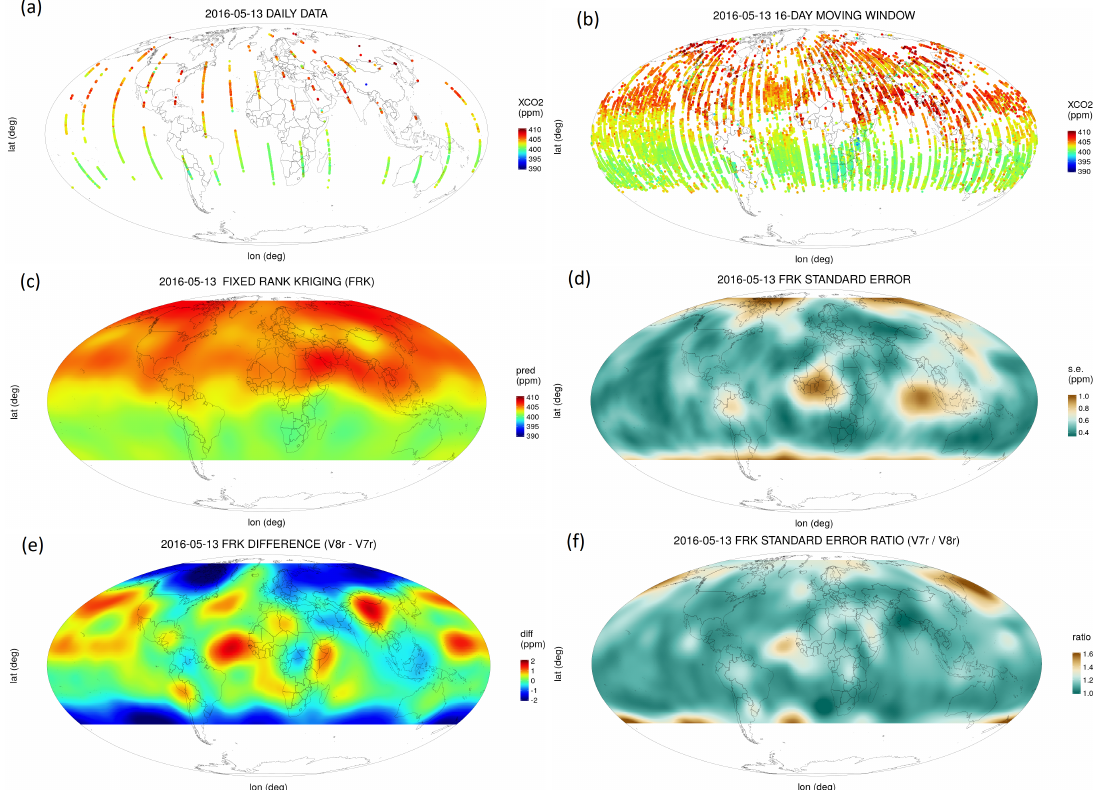
Figure 8. Fixed rank kriging (FRK) predictions of XCO 2 for 13 May 2016. ( a ) Orbiting Carbon Observatory-2 (OCO-2) Version 7r Lite File XCO 2 data with warn levels ≤ 15 on 13 May 2016; ( b ) same as (a), but for data between 6 May 2016 and 21 May 2016, inclusive; ( c ) global FRK Version 7r prediction (pred) of XCO 2 ; ( d ) global FRK Version 7r prediction standard errors (s.e.) ; ( e ) the difference (diff) between the FRK Version 8r predictions and those of FRK Version 7r for 13 May 2016; ( f ) the ratio of the FRK Version 7r prediction standard errors to those of FRK Version 8r for 13 May